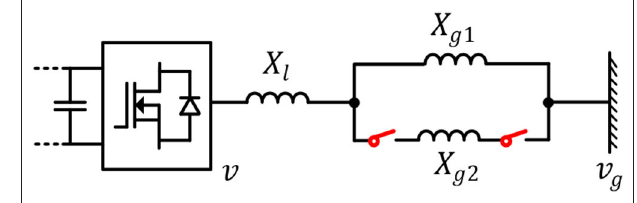
FIGURE 8 | A grid-connected GFM converter